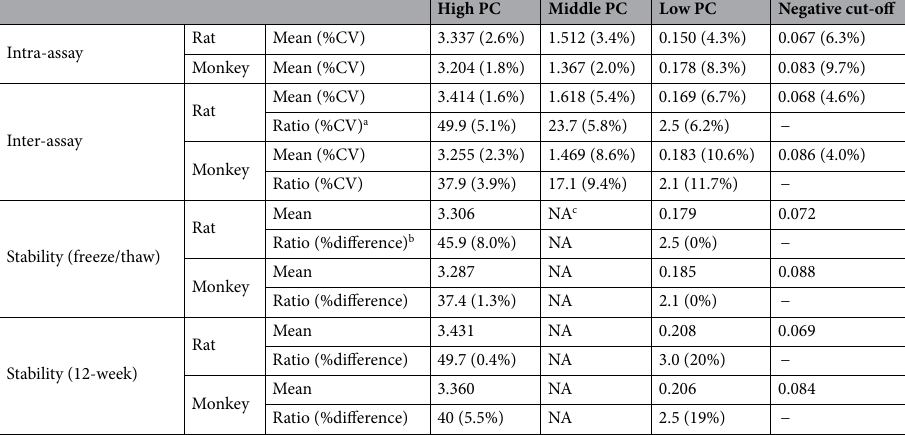
Table 1. Repeatability (intra-assay precision) and reproducibility (inter-assay precision). a Ratio of absorbance of the PC to absorbance of the negative cut-off. b Absolute value of %difference from precision. c Not applied.